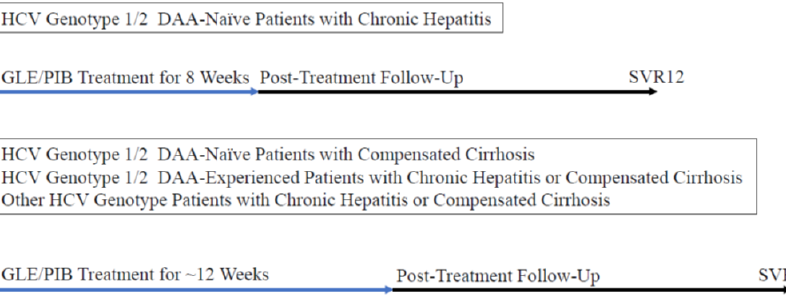
Figure 1. Treatment regimens in the groups of various patients. DAA, direct-acting antiviral; GLE/PIB, glecaprevir/pibrentasvir; SVR12, sustained virologic response at 12 weeks after the end of treatment.